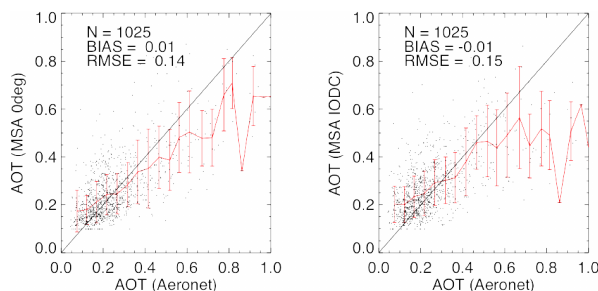
Figure 5. Comparison of AERONET and MSA aerosol optical depth (AOD). Left panel: 0DEG coverage, right panel: IODC_57 and